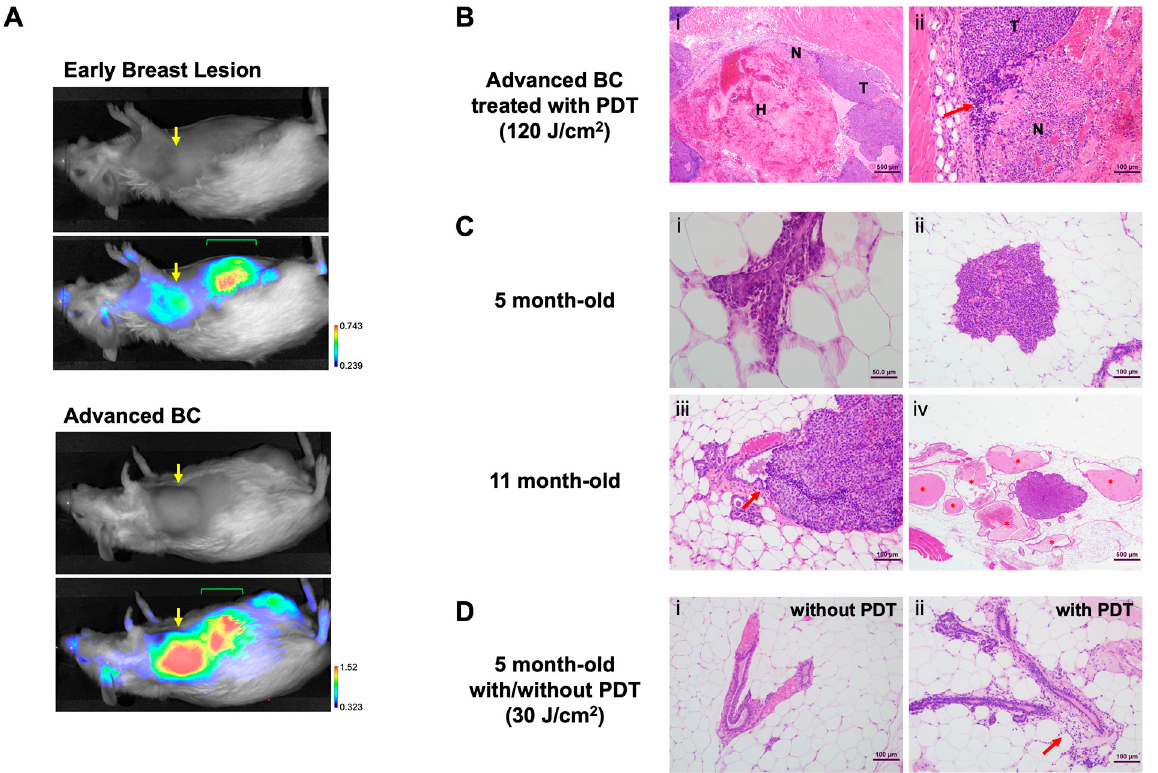
Figure 3. Development of DCIS lesions in MMTV-neu mice. ( A ) An MMTV-neu mouse at the age of 7 months with DCIS lesion in the right #3 mammary gland and another mouse at the age of 10 months with an advanced breast tumor were administered HS201 (25 nmol/mouse) via tail vein injection, and 6 h later, nIR images were taken using LI-COR Pearl imager. Yellow arrows indicate the locations of the breast lesions. At this stage of imaging, HS201 was mostly secreted into bile, then into the intestine and detected as nIR signals in the abdomen (green mark). ( B ) Pathological analyses of HS201-PDT-treated breast cancers in MMTV-neu mice. ( i ) Low magnification photomicrograph of MMTV-neu mammary carcinoma treated with HS201-PDT showing extensive hemorrhage (H) and necrosis (N). H&E bar = 500 µ m. ( ii ) High-magnification photomicrograph of mass (i) showing